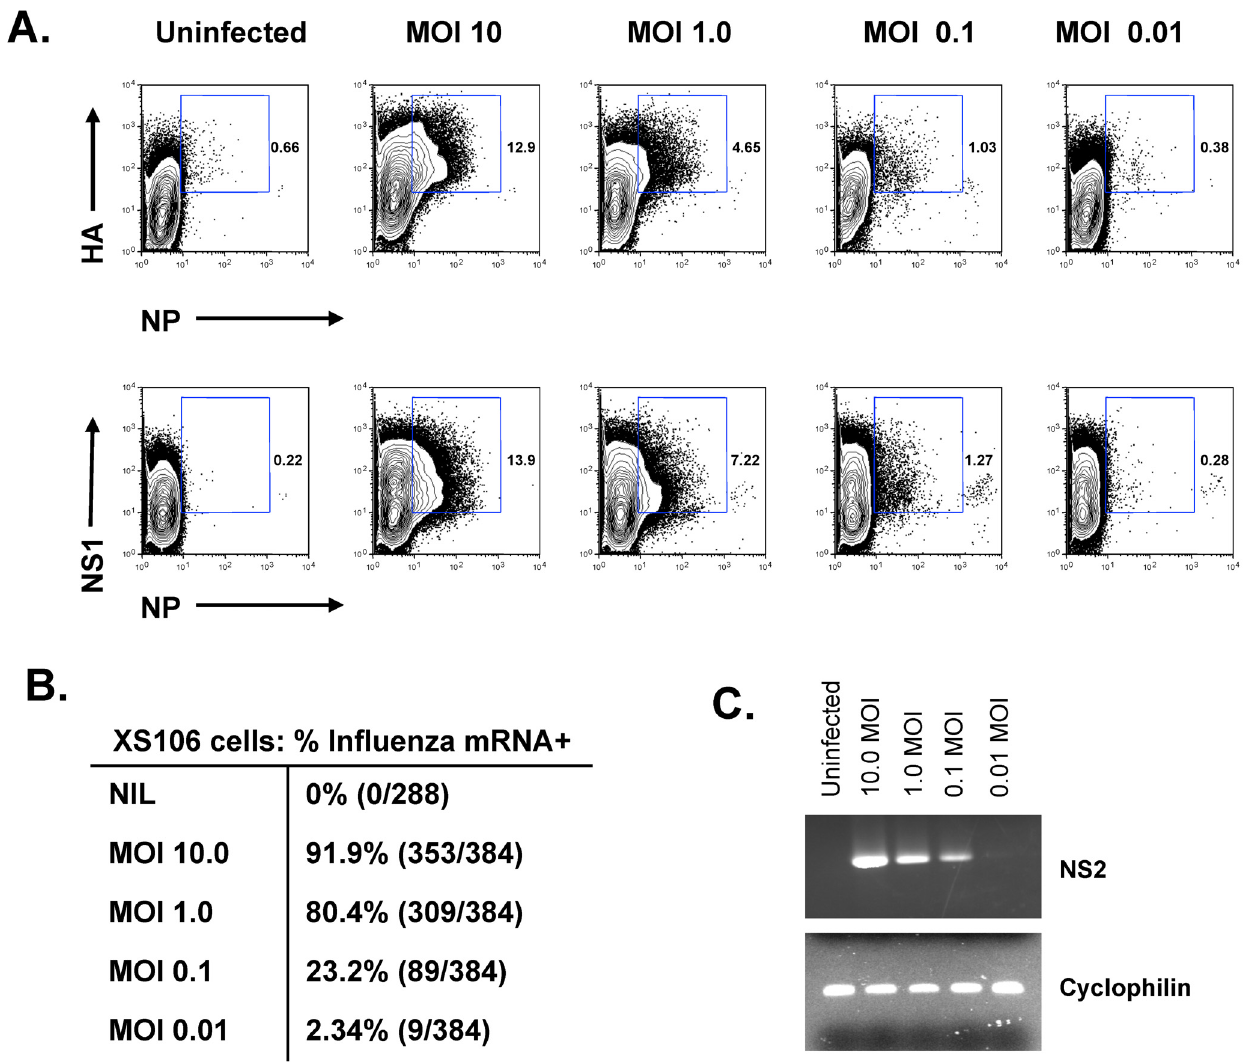
Figure 1. Single cell RT-PCR and flow cytometry following increasing MOI in the dendritic-like cell line XS106. XS106 cells were infected with 0, 0.01, 0.1, 1 and 10 MOI of IAV. 18 hours p.i., cells were harvested and analyzed by flow cytometry (A) for the IAV proteins hemagglutinin (HA) and nucleocapsid protein (NP) (top panels) or HA and nonstructural-1 (NS-1) (bottom panels) or (B and C) single-cell PCR for the viral nonstructural protein 2 (NS-2) mRNA. Data are representative of 2 separate experiments. Cyclophilin normalized intensities in C; 0.865: 10 MOI; 0.640: 1MOI; 0.388: 0.1MOI; 0.068: 0.01MOI.